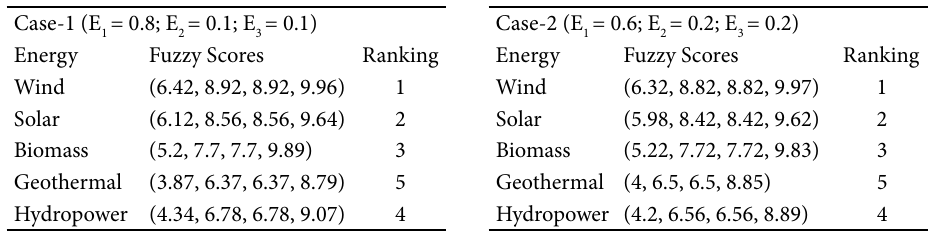
Table 5. results of sensitivity analysis based on experts’